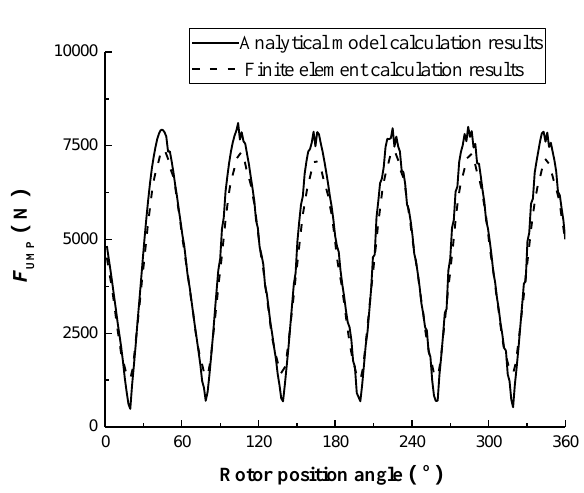
Figure 13. The UMP direction of rotor in fault.